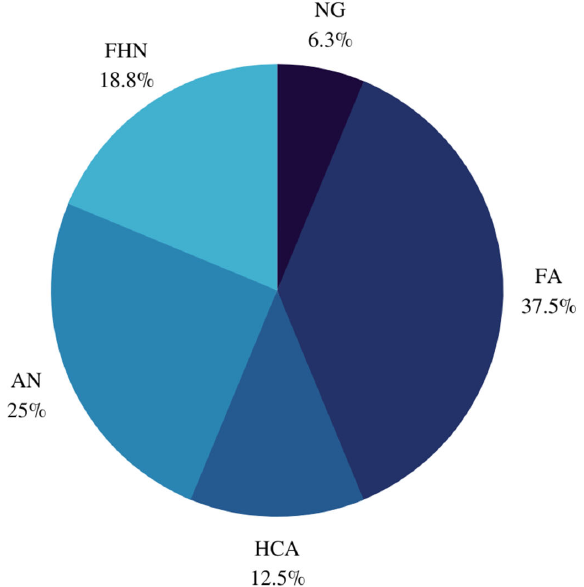
Figure 2. Histopathological diagnoses of benign nodules. NG: Nodular goiter. FA: Follicular adenoma; HCA: Hurthle cell adenoma, AN: Adenomatoid nodule, FHN: Follicular hyperplastic nodule.